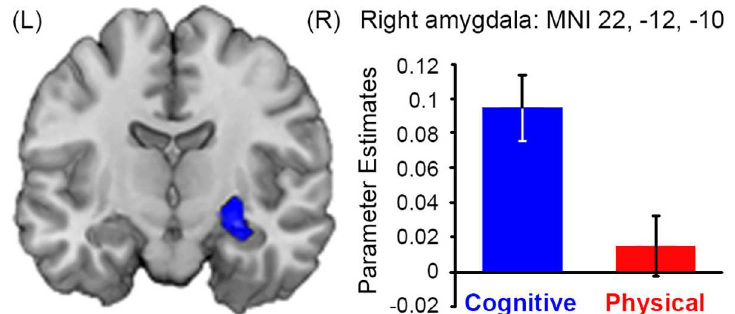
Fig 5. The right amygdala uniquely trackedthe SV of rewards associated with cognitive costs. Coronalsection showingactivity within the right amygdalathat parametrically varied with SV of the cognitive (but not physical) offer. Underlyingdata be found in S1